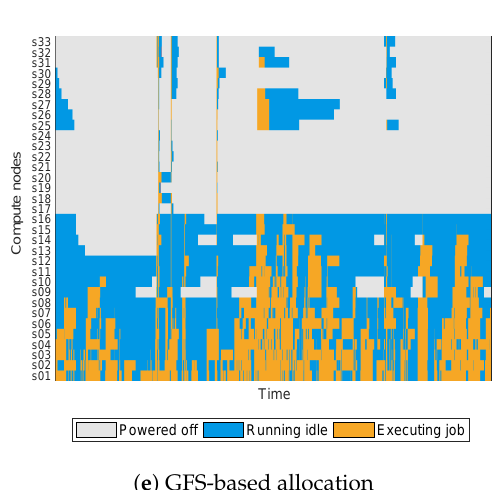
Figure 5. Compute node status over time for the test set of the CMS